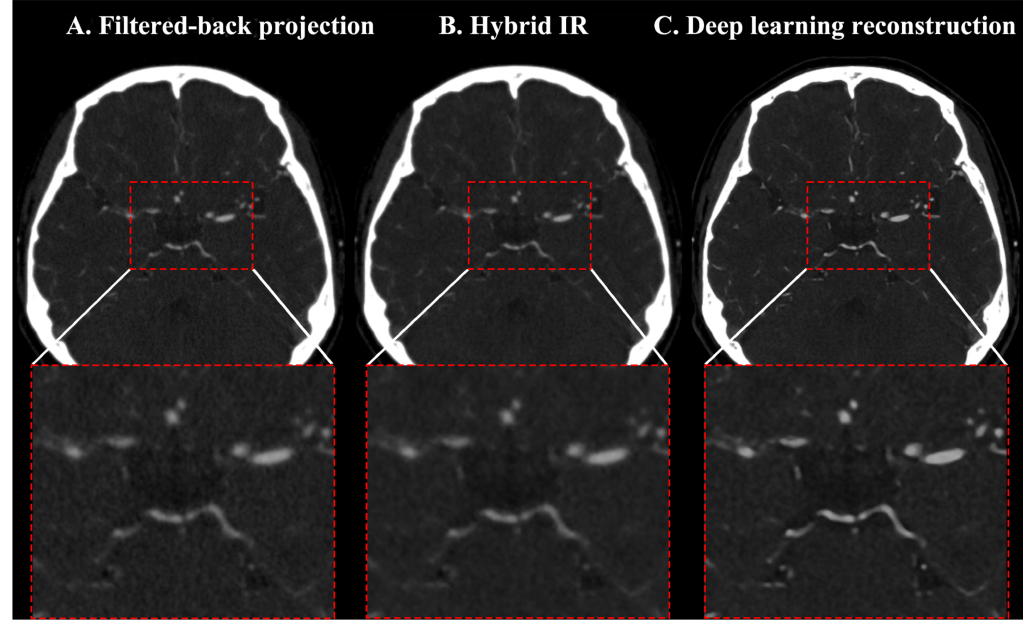
Fig. 6. Axial cut brain CTA images for visualization of intracranial vessel. Comparison of brain CTA between filtered-back projection (A), hybrid iterative reconstruction (IR) (B), and deep learning reconstruction (C) in the vessel visualization. The deep learning reconstructions (C) demonstrated a good vessel delineation wall with minimal image noise and sharp vessels compared to hybrid iterative (B) and filtered back projection (A) algorithms. The circle of Willis can be clear on the magnified images of the red dashed outlines. The image quality of the deep learning reconstruction was assessed by 4 scores, 3 scores for hybrid iterative reconstruction, and 2 scores for filtered-back projections by observer